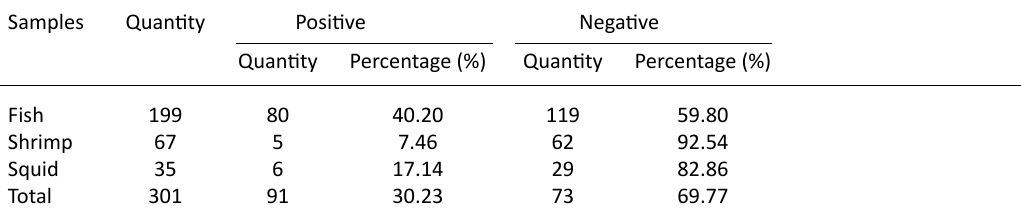
Table 2. The percentage of Salmonella spp. detection in raw seafood samples Samples